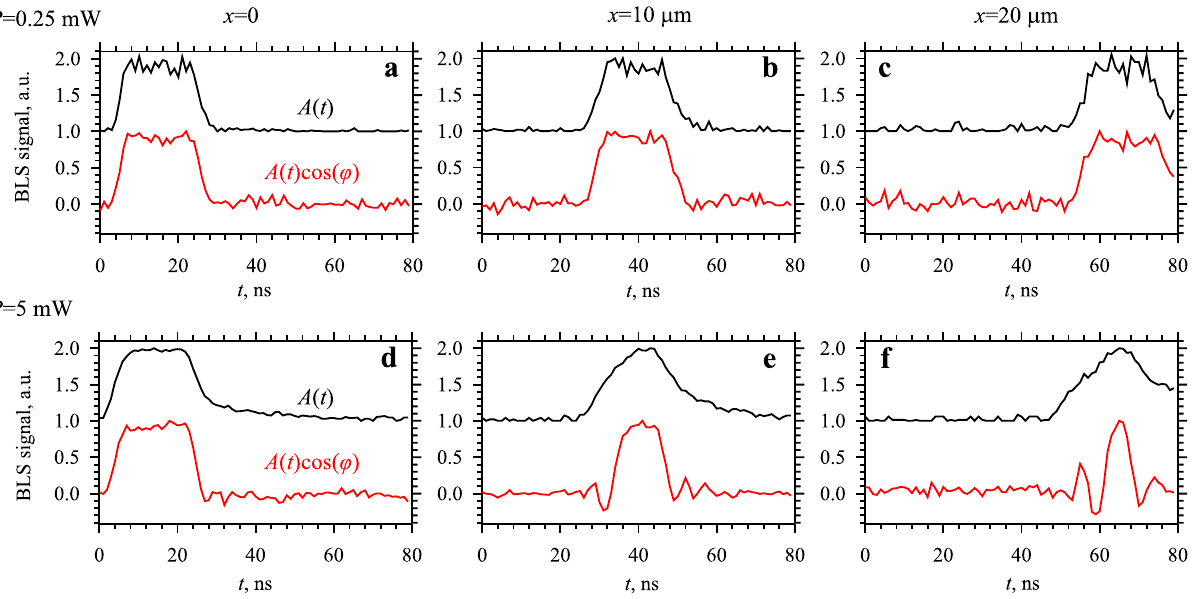
Figure 6. Effects of self-phase modulation in the time domain. Measured temporal profiles of the amplitude envelope of the pulse A ( t ) (shifted for clarity) and phase-resolved profiles A ( t )cos( φ ( t )), as labelled. ( a ), ( b ), and ( c ) show the data recorded at P = 0.25 mW. ( d ), ( e ), and ( f ) show the data recorded at P = 5 mW. ( a ) and ( d ) are recorded at x = 0, ( b ) and ( e ) are recorded at x = 10 µm, ( c ) and ( f ) are recorded at x = 20